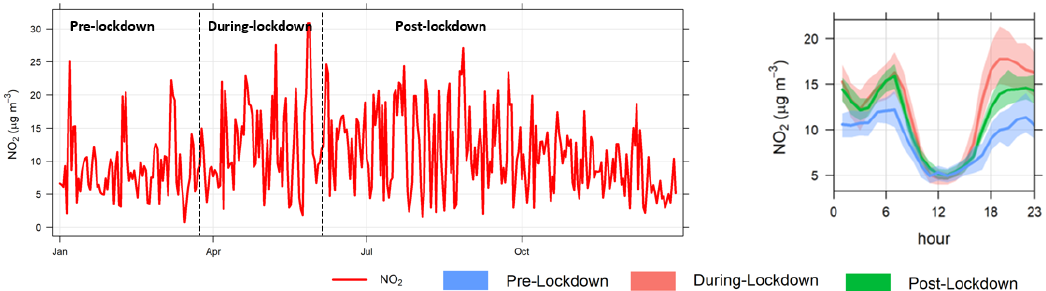
Figure 6. The variation in 24 h concentrations and hourly diurnal profile of NO 2 at Rocklea monitoring station for different periods.